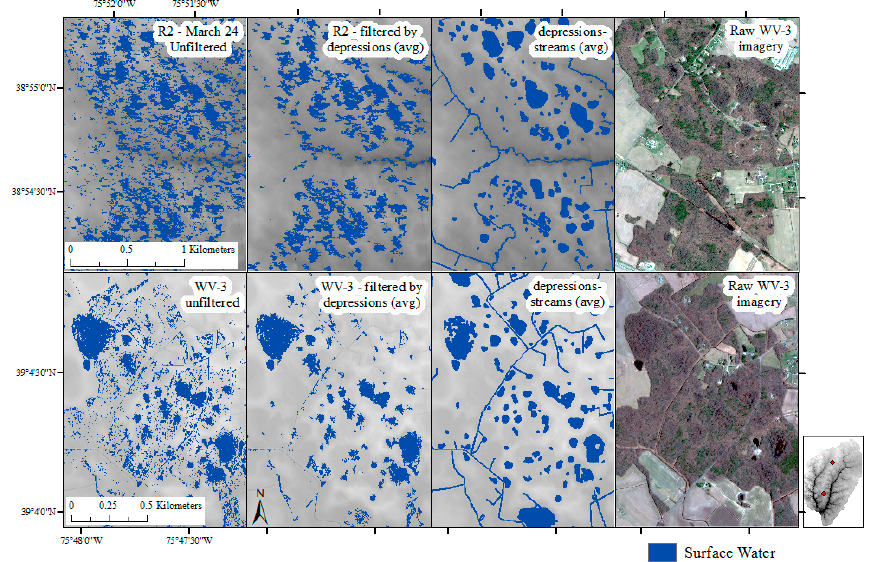
Figure 7. The effect of filtering the Radarsat-2 (R2; top, southern location) and Worldview-3 (WV3; bottom, northern location) outputs by the lidar-derived depressions. Copyright 2017 Digital Globe, Next View License.